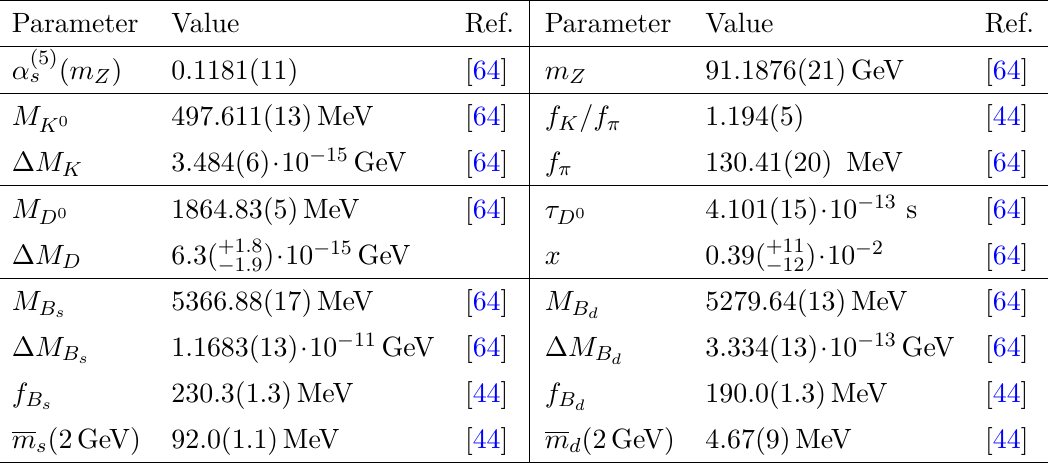
Table 1 . Numerical input values for parameters entering the conversion of bag factors to matrix elements and the LEFT master formula (2.15). The values of the strange- and down-quark masses in the MS scheme are the N f = 2 + 1 averages of lattice determinations from the FLAG group from [65–70]. The B q -meson decay constants f B are averages from the FLAG group for N f = q 2 + 1 + 1 from [71–74]. They are almost identical to the single determination of FNAL/MILC f B = 230 . 7(1 . 3) MeV and f B = 190 . 5(1 . 3) MeV [71]. We determine ∆ M D = x/τ D 0 with the value s d of x from a global fit when allowing CP violation in all decays [64], for comparison it would be x = 0 . 50( +13 ) · 10 − 2 assuming no CP violation. − 14